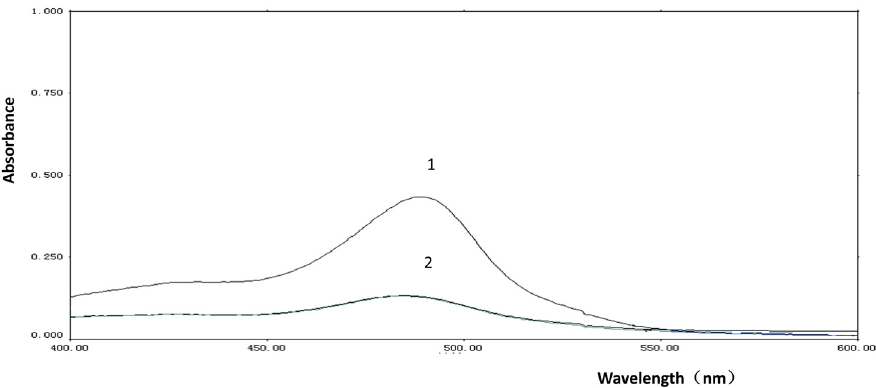
Figure 1: UV absorption curve of B. rynchopetera extract and glucose standard solution. ( 1 ) Glucose standard solution, ( 2 ) sample solution of B. rynchopetera